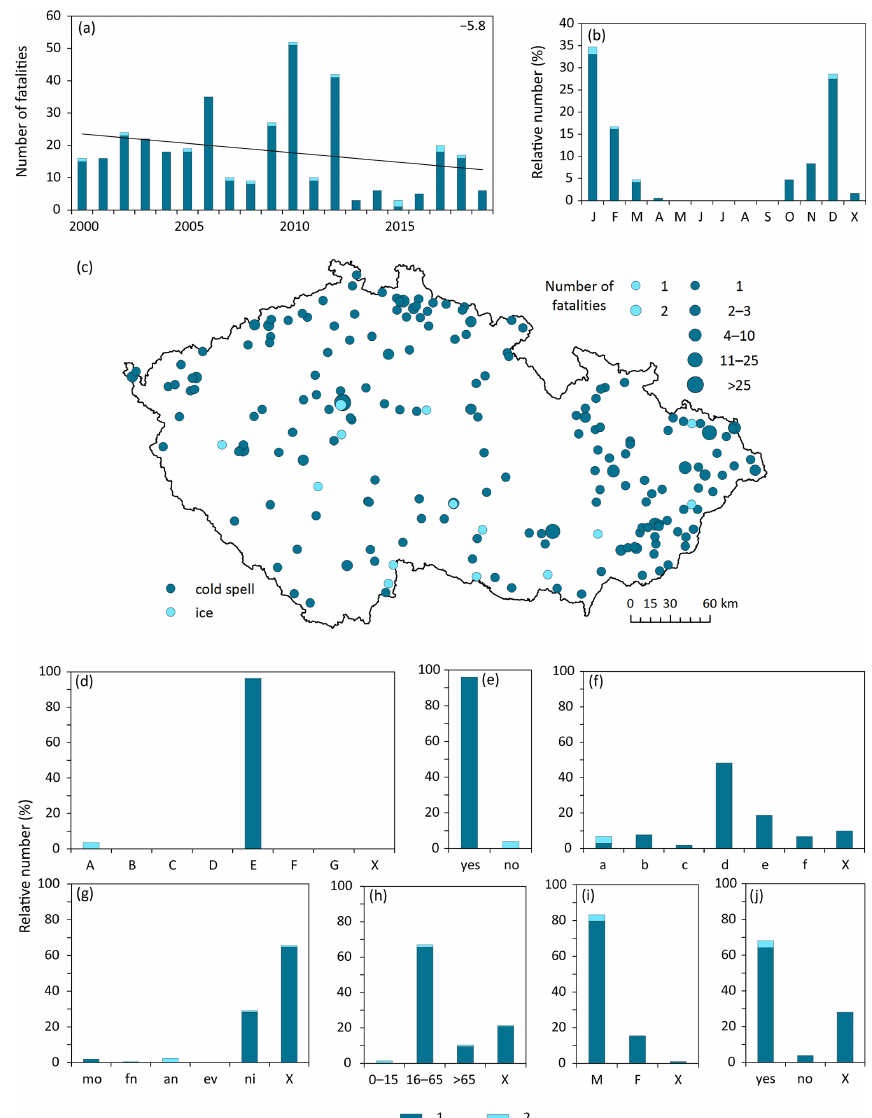
Figure 7. Characteristics of frost-related fatalities (1 – cold spell, 2 – ice) in the Czech Republic during the 2000–2019 period: (a) fluctuations with linear trend (top right, fatalities/10 years), (b) annual variation, (c) spatial distribution (six fatalities lack exact location), (d) cause of death, (e) type of fatality, (f) place of death, (g) part of the day, (h) age, (i) sex, (j) behaviour. For explanation of symbols and abbreviations see Fig.